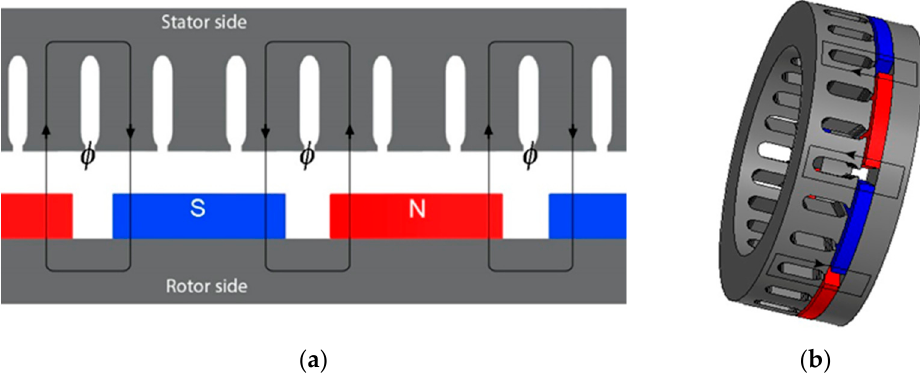
Figure 2. Magnetic flux path of the AFPM machine in ( a ) the 2D view and ( b ) the 3D view.